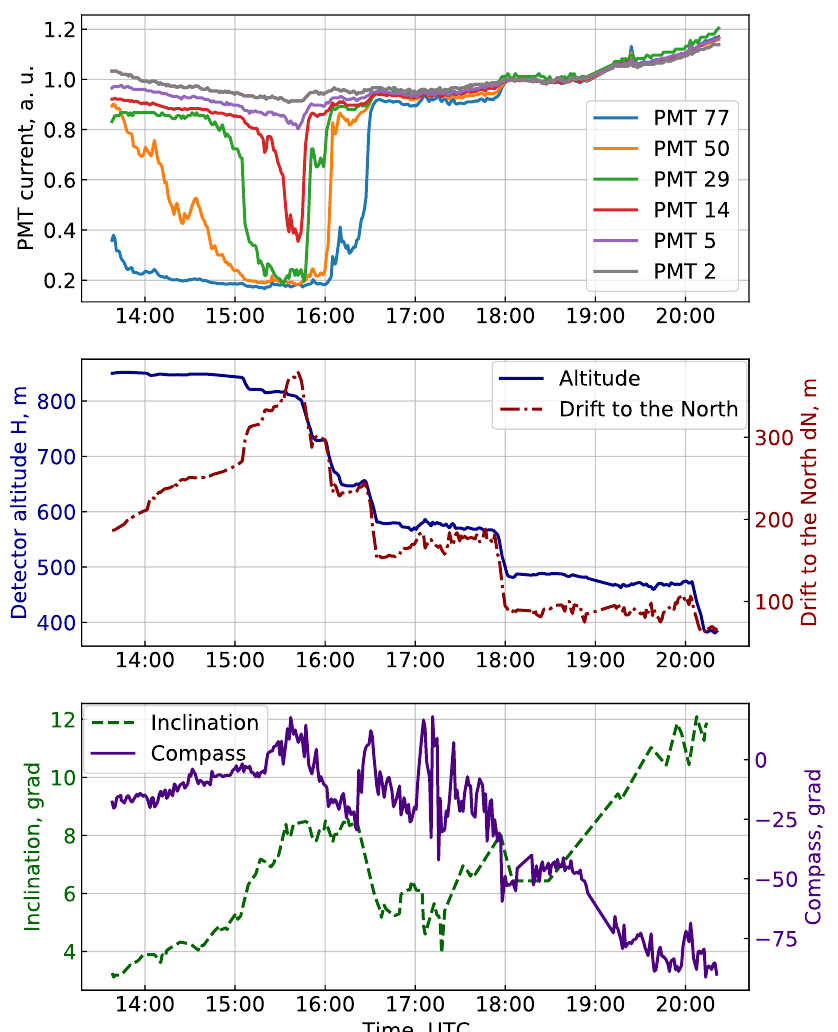
Figure 11. PMT currents, detector altitude, drift to the North, compass, and inclination during flight